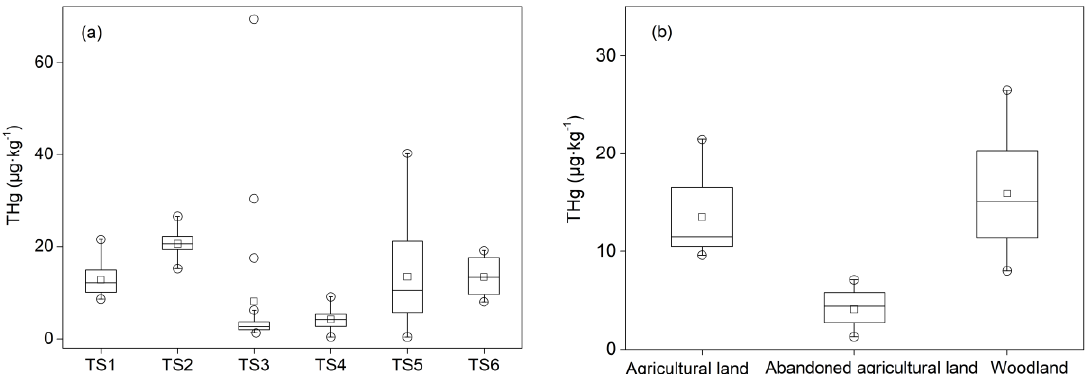
Figure 2. ( a ) The content of THg in each profile and ( b ) the content of THg in different land use types (0–30 cm) (o represents outliers, and □ represents mean values).